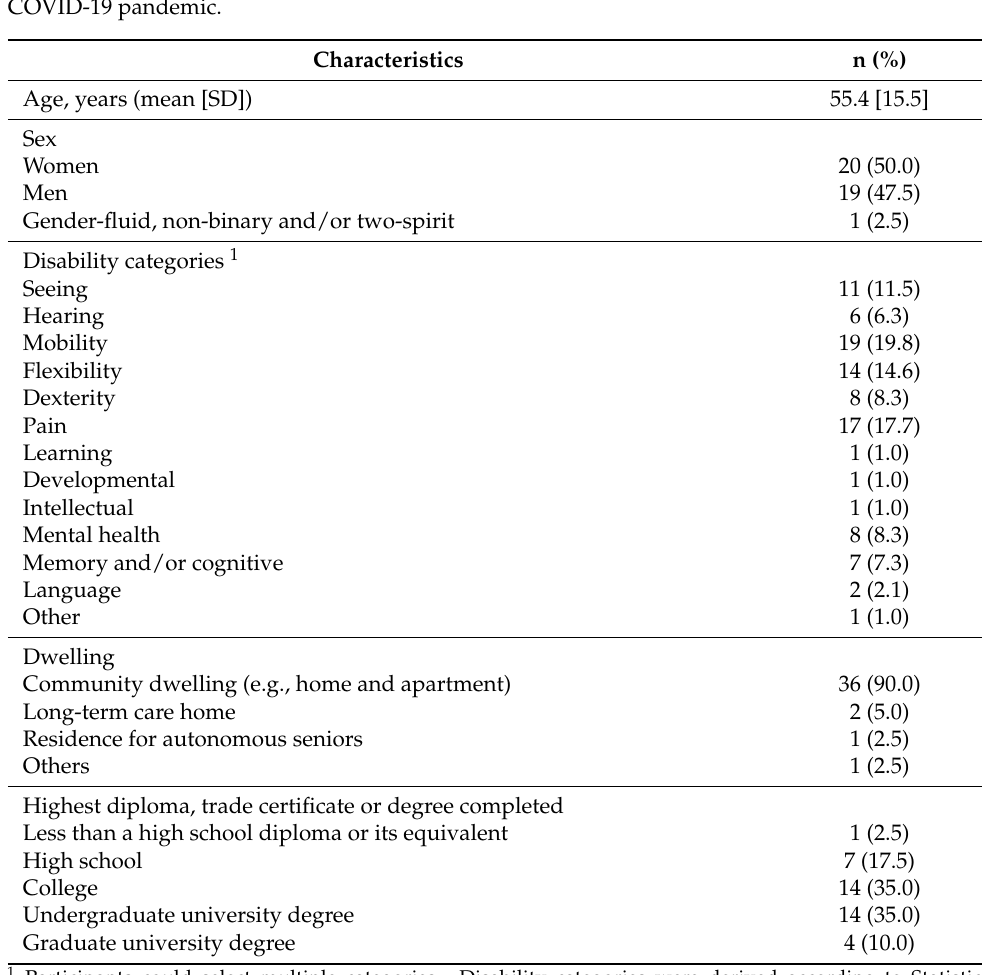
Table 1. Characteristics of 40 people with disabilities from Quebec province (Canada) during the COVID-19